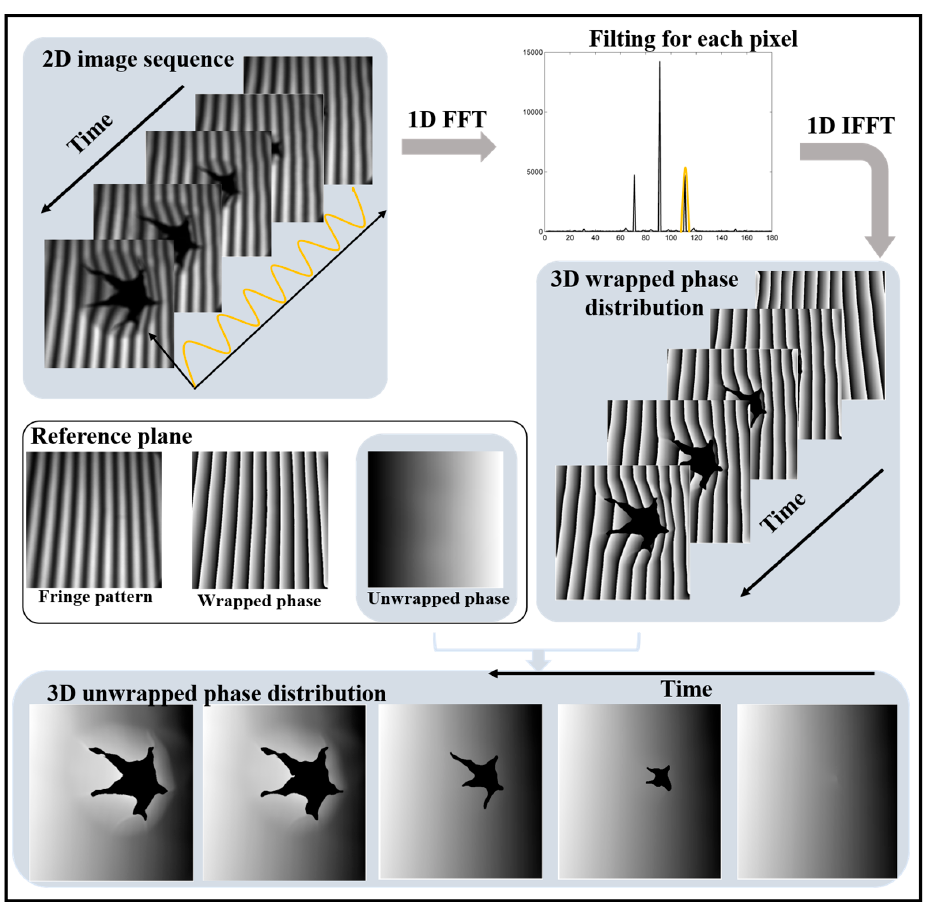
Figure 4. Computational framework of our proposed 3-D reconstruction method.